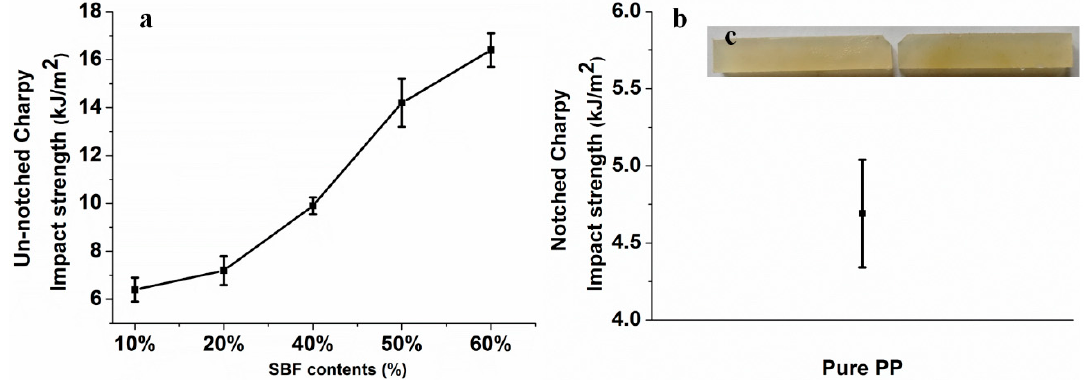
Figure 4. Impact strength of the composites and pure PP: ( a ) the un-notched charpy and ( b ) notched charpy of PP; ( c ) image of the PP after the impact test.